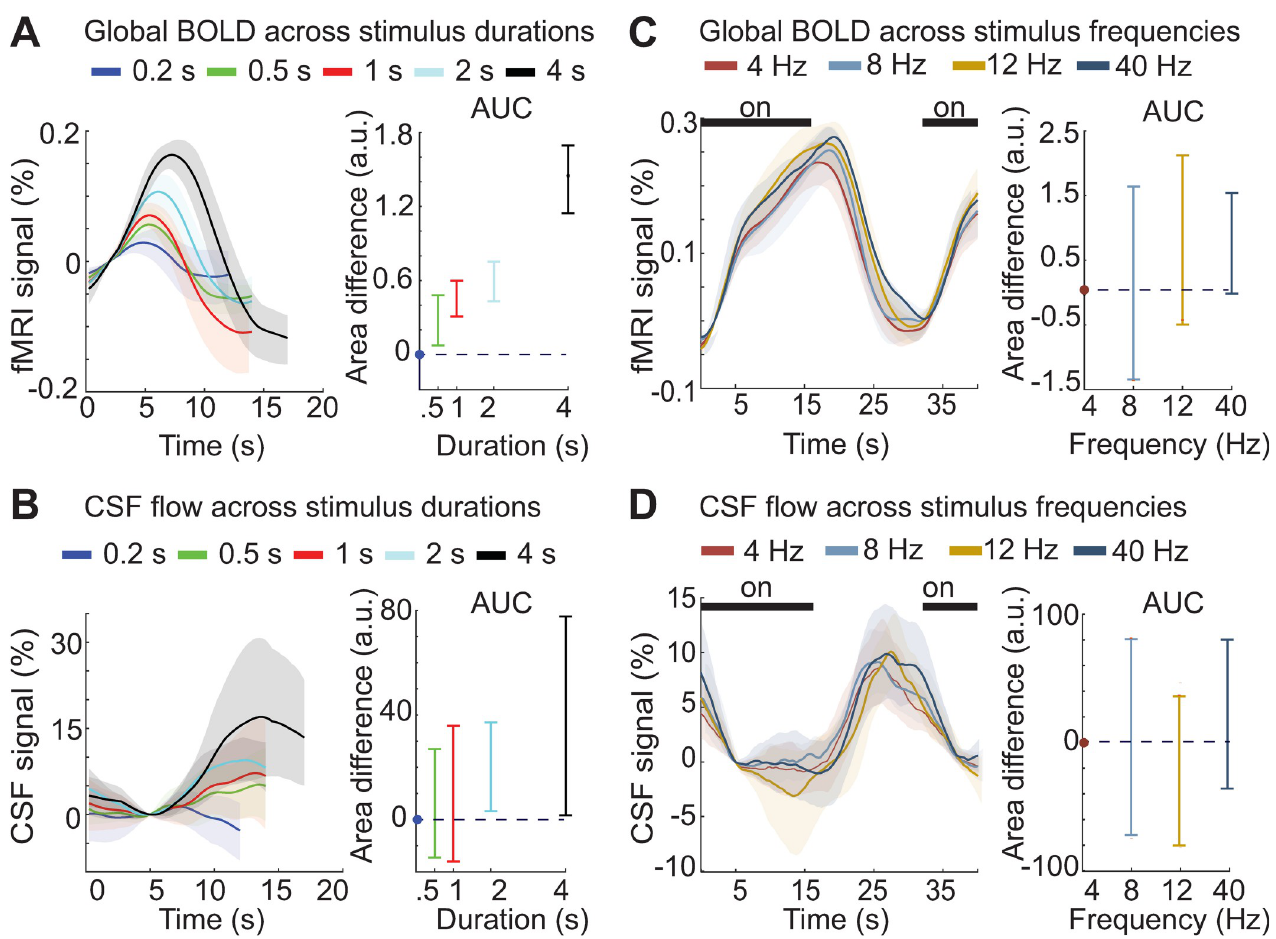
Fig 3. CSF responses match cortical hemodynamic responses across a range of stimulus parameters. ( A ) Left : Traces show the mean deconvolved cortical responses across subjects for each stimulus duration ( n = 105 runs, 12 subjects). Colors represent the duration (0.17–4 s) of ON blocks, consisting of a 12-Hz flickering checkboard. Shading represents the 95% confidence intervals (bootstrap analysis). Right : The average area under the curve of the cortical BOLD response increases as a function of stimulus duration. Error bars represent the 95% confidence interval (bootstrap analysis, Bonferroni corrected). ( B ) Left: Traces are the mean deconvolved CSF flow signals for each stimulus duration. Shading represents the 95% confidence intervals (bootstrap analysis). Right : The average area under the curve of the CSF response increases as a function of stimulus duration, matching the pattern seen in BOLD. Error bars represent the 95% confidence interval (bootstrap analysis, Bonferroni corrected). ( C ) Left: Average stimulus-locked cortical responses across stimulus flicker frequencies. Shading indicates standard error across subjects ( n = 143 runs, 16 subjects). Right : Average difference in the area under the curve of the cortical BOLD response for the 3 higher stimulus frequencies with the 4-Hz condition. Error bars show the 95% confidence intervals (bootstrap, Bonferroni corrected). ( D) Left: Average stimulus-locked CSF responses also show no significant change across flicker frequencies. Shading indicates standard error across subjects. Right : Average area under the curve for the CSF responses does not change significantly across stimulus frequencies. Error bars represent the 95% confidence interval (bootstrap, Bonferroni corrected). Dashed lines indicate y = 0; dots indicate the value used to normalize area for each subject, which was the shortest duration (0.17 s) or the lowest frequency (4 Hz). Data from: doi:10.18112/openneuro.ds004484.v1.0.0 (Experiment 2), doi:10.18112/openneuro.ds004493.v1.0.0 (Experiment 3). BOLD, blood-oxygenation-level-dependent; CSF, cerebrospinal